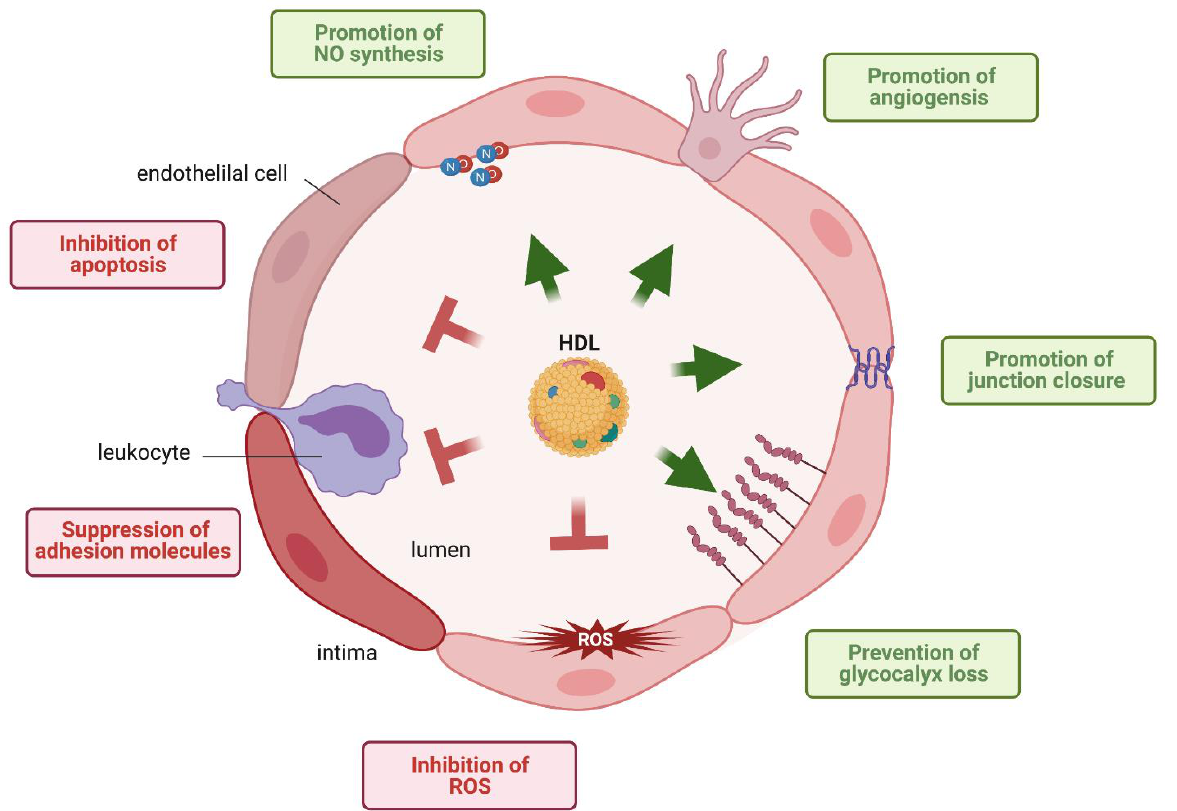
Figure 1. Vasoprotective functions exerted by HDL on the endothelium. HDL increases (green) vasoprotective functions and suppresses (red) harmful functions of the endothelium.